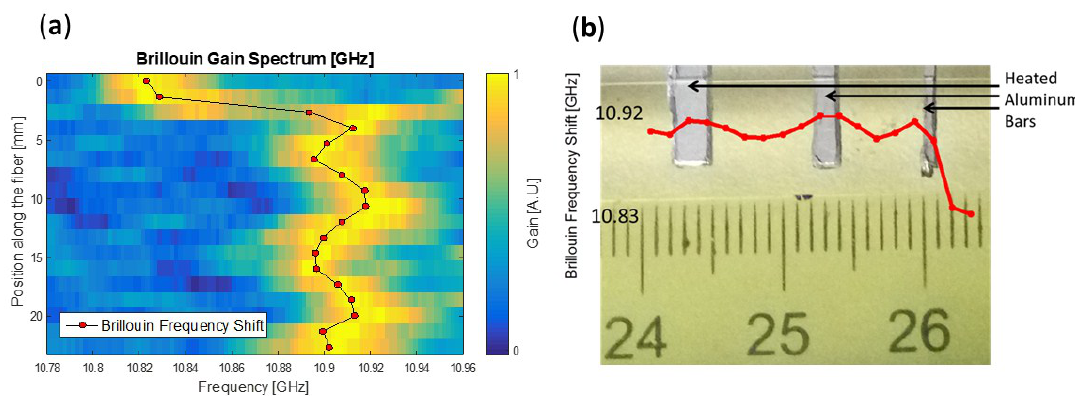
Figure 11. Amplified spontaneous emission (ASE)-based B-OCDA. ( a ) Map of normalized Brillouin gain as a function of correlation peak position and frequency offset between pump and signal waves. Red dots indicate the estimated local Brillouin frequency shifts in each measurement location. ( b ) Top view image of the fiber under test alongside a scale bar (in cm). Three local hot-spots are introduced through the attachment of the fiber to heated aluminum bars. The red trace shows the measured local Brillouin frequency shifts (same as panel ( a )) as a function of position on the same scale. The left and central hot-spots, with widths of 3 mm and 2 mm, respectively, are properly identified in the